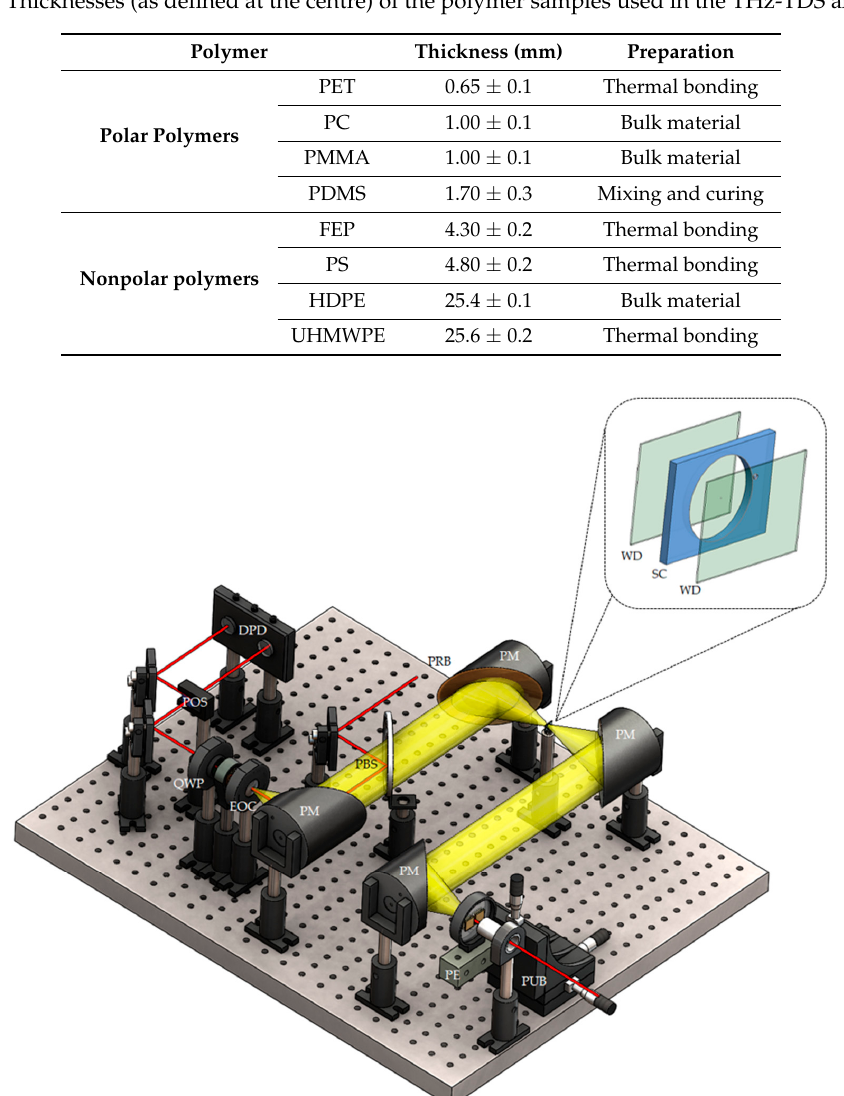
Figure 1. Isometric schematic of THz time-domain spectroscopy (THz-TDS) system, with the microfluidic platform at the top right. Ultrafast laser pulses are split into two beams: a pump beam (PUB), focused on the photoconductive SI-GaAs THz emitter (PE), and a probe beam (PRB). The THz beam (yellow) is generated at the emitter and then collected, collimated, and focused by parabolic mirrors (PMs). The probe beam is overlaid with the THz beam by a pellicle beamsplitter (PBS).